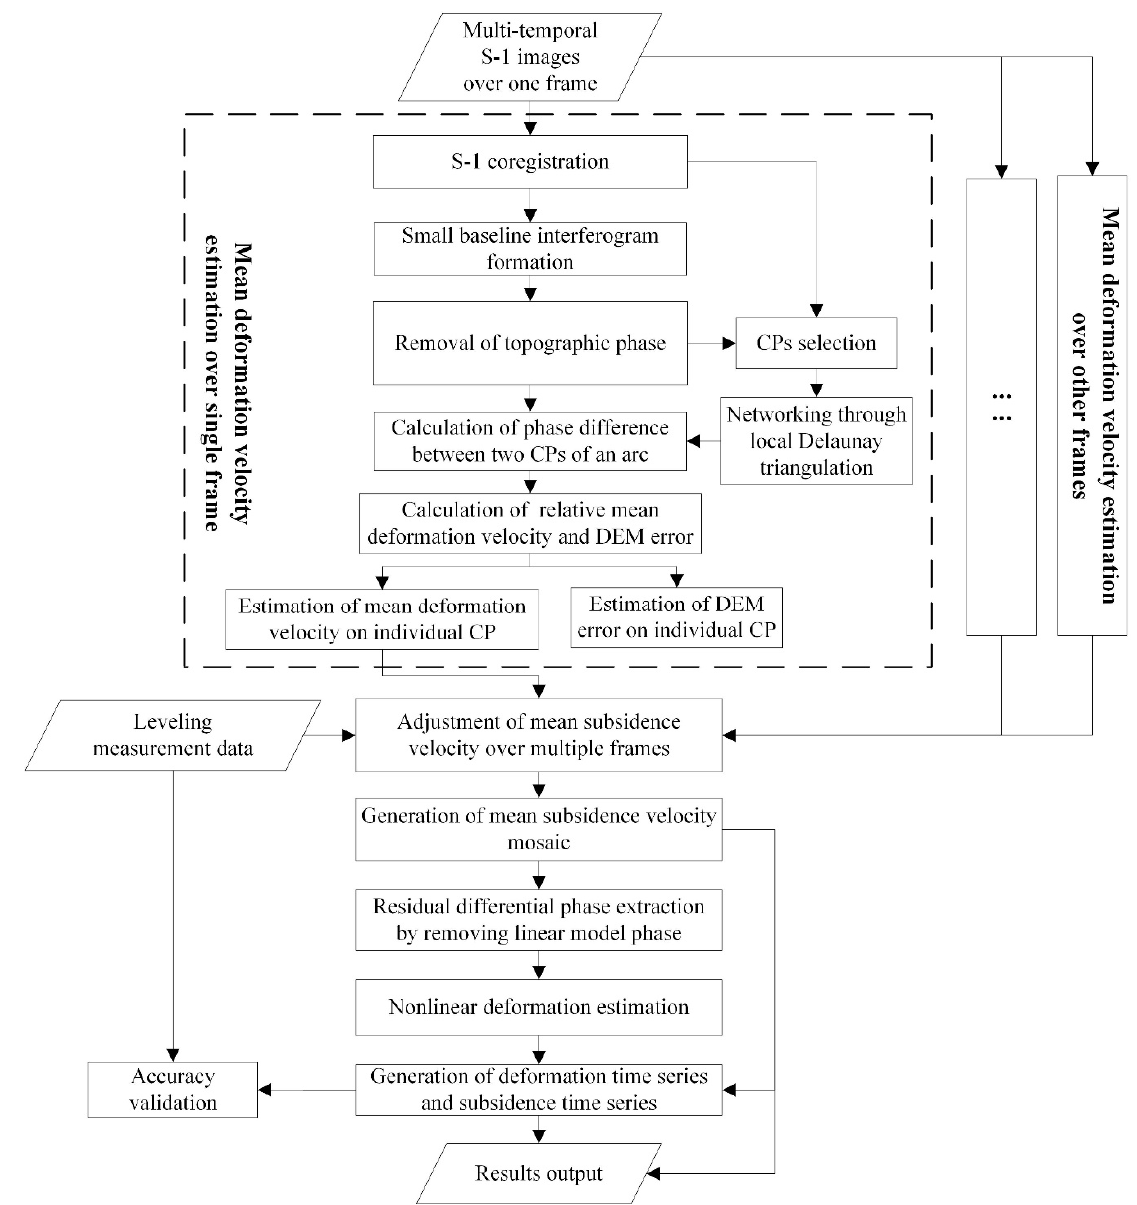
Figure 2. The flow chart of time series analysis of the S-1